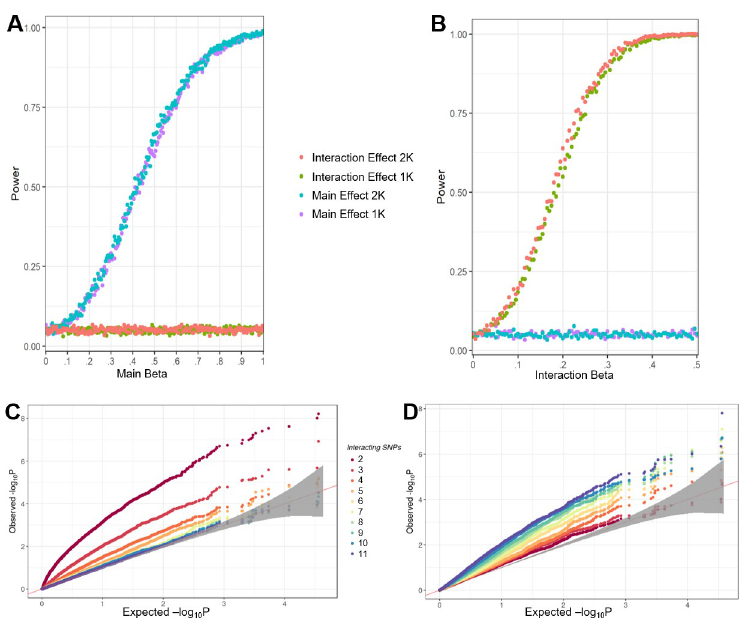
Fig 1. Simulation results A+B) Power calculations based on simulated data with variable main SNP effects β G (A) or variable Ancestry-SNP effects β Gx (B). Blue and Purple power curves are the power curves for detecting a significant θ SNP effect, while the orange and green curves are the power curves for detecting a significant Gx θ effect. Two phenotypic models, one incorporating 1 GRM (1K) correcting for relatedness in the SNPs (green, purple) and one incorporating 2 GRMs (2K) correcting for relatedness in both SNPs and Ancestry (red, blue) were used. (C+D) Effect of increasing numbers of epistatically interacting SNPs on the algorithms ability to detect a significant main SNP effect (C) or Gx θ effect (D). The straight line in C and D represents the line where expected and observed P values are the same, while the grey band indicates the 95% confidence interval in which the observed P-value distribution cannot be distinguished from the expected P-value distribution.